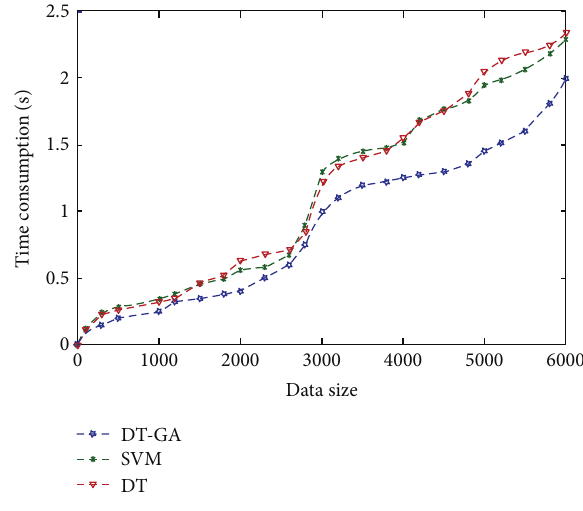
Figure 10: Time consumption